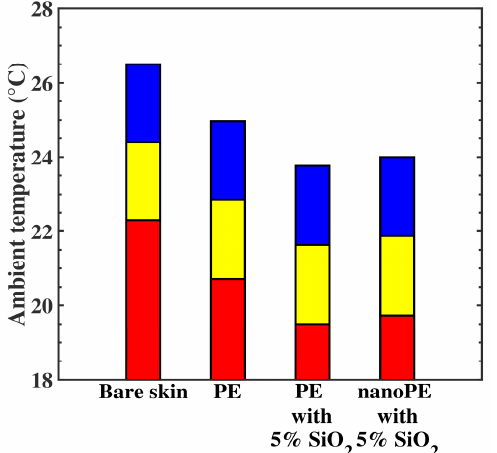
Figure 6. Room temperature for thermal comfort when the human body is covered with PE membrane free of submicron particles, PE membrane containing 5% SiO 2 , and nanoPE membrane containing 5% SiO 2 , compared to bare skin. The thickness of the membranes is 150 µm. The calculation was done for three skin temperatures of thermal comfort, T s = 30 °C ( red ), T s = 32 °C ( yellow ), and T s = 34 °C ( blue ). All previous calculations were done considering a plane wave under normal incidence.